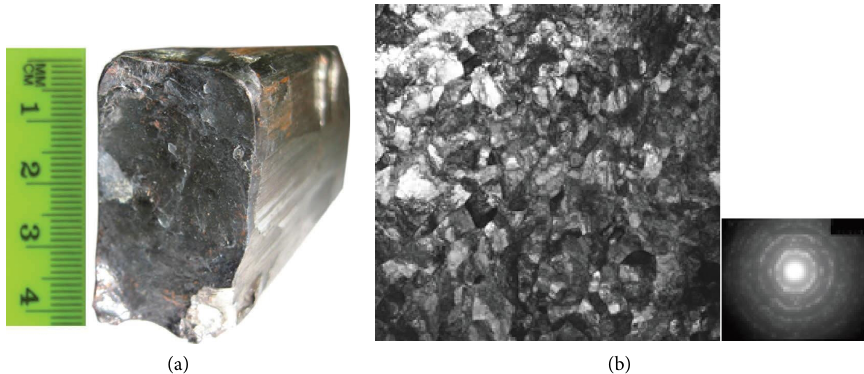
Figure 3: General view ( a ) and microstructure (b) of a billet after four passes of processing with TE. Billet dimensions after TE: billet section is 39 × 24mm; length is 80mm.